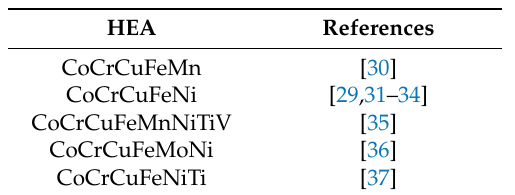
Table 1. High-entropy alloys (HEAs) studied in the literature that contain equiatomic CoCrCu with Cu-rich phase